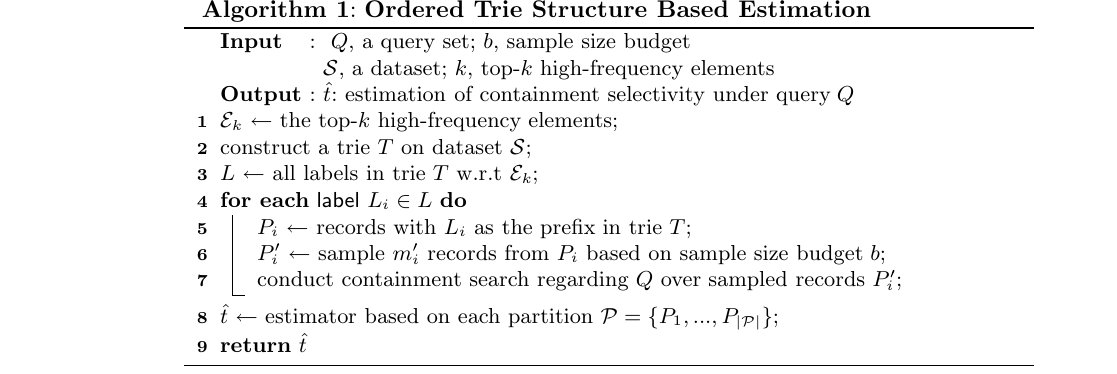
Algorithm 1 : Ordered Trie Structure Based